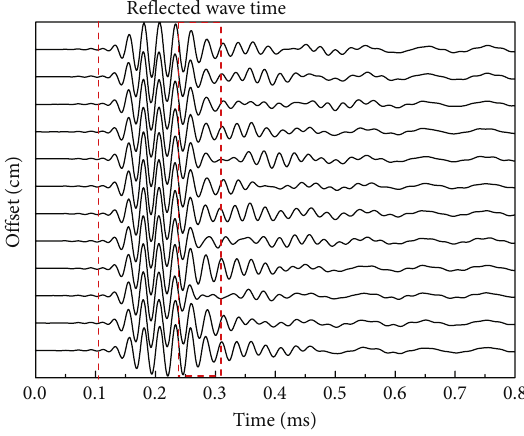
Figure 3: The YY waveform of common o ff set gather in